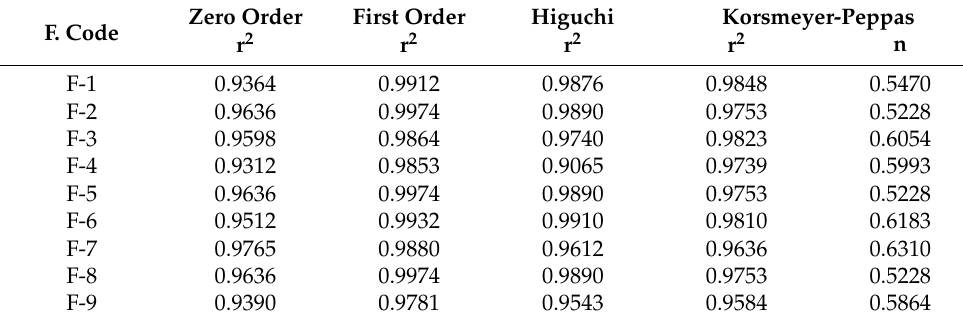
Table 3. Kinetic modeling release of 5-ASA from CS/ β -CDcPAa hydrogels.